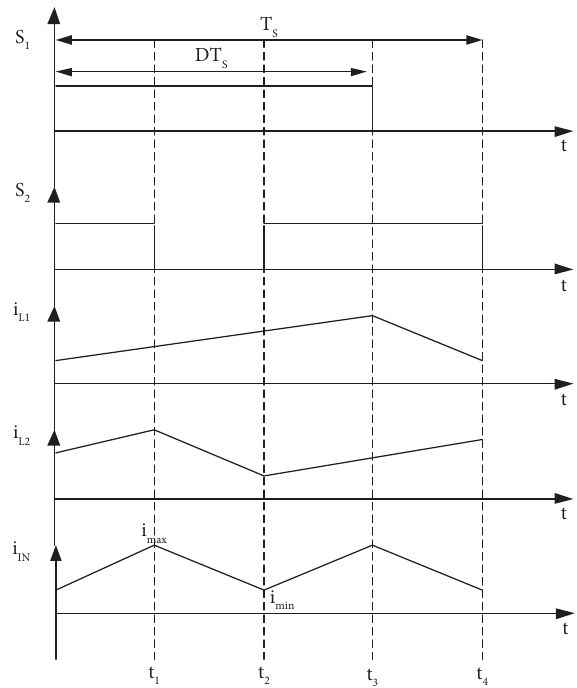
Figure 8: DB converter switching